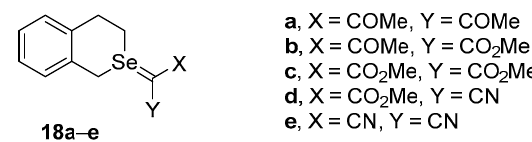
Figure 12. Cyclic exo -selenonium ylides 18a – e based on the dihydro-2-benzoselenin cycle.